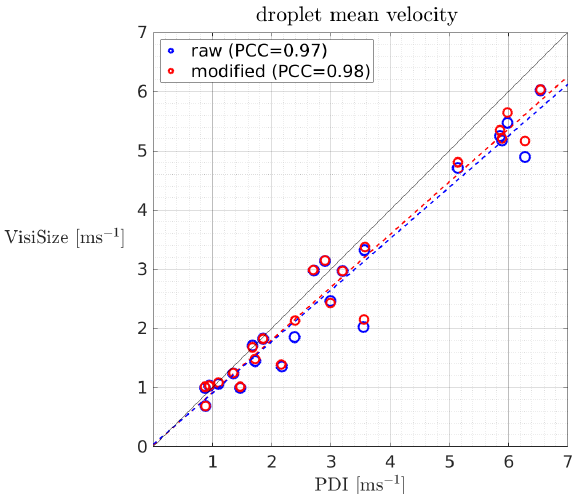
Figure 8. Comparison of the mean droplet velocity between the Vi- siSize and the PDI probe. Each pair of blue and red circles indi- cates the raw/modified data for a selected measurement of ∼ 15min. Dashed lines show the least squares regression (LSR), and the PCCs are displayed in the